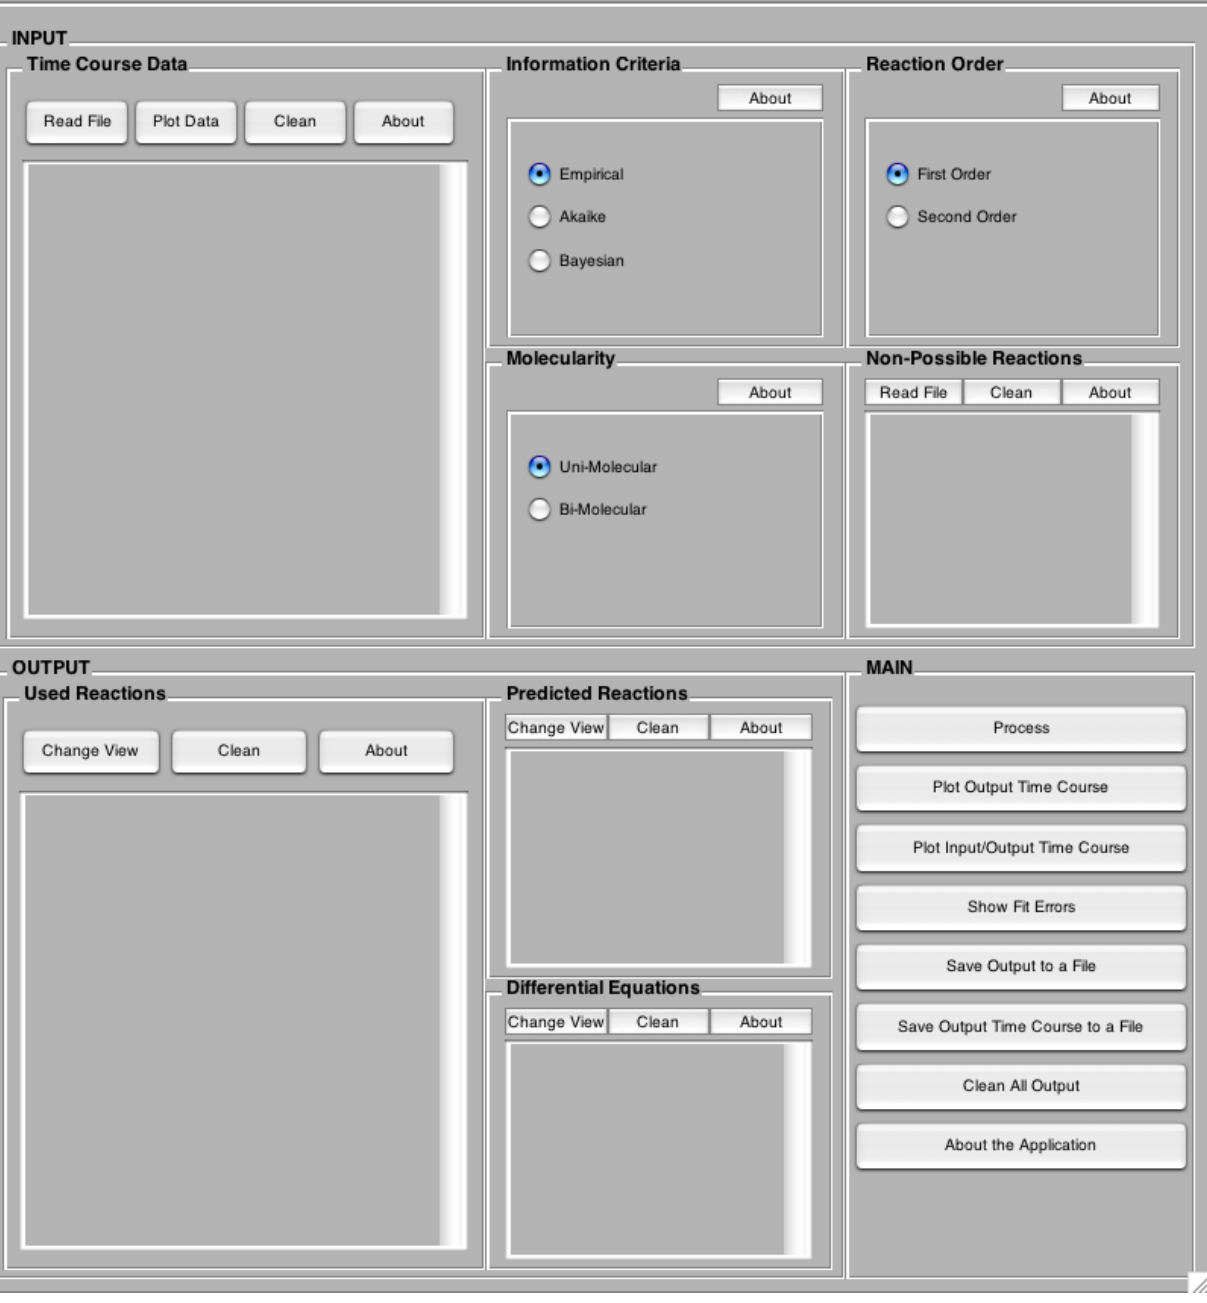
Figure 1. MIKANA’s Graphical User Interface (GUI). The GUI is composed of three main panels: (i) the INPUT panel (at the top); (ii) the OUTPUT panel (at the bottom left); and (iii) the MAIN panel (bottom right).